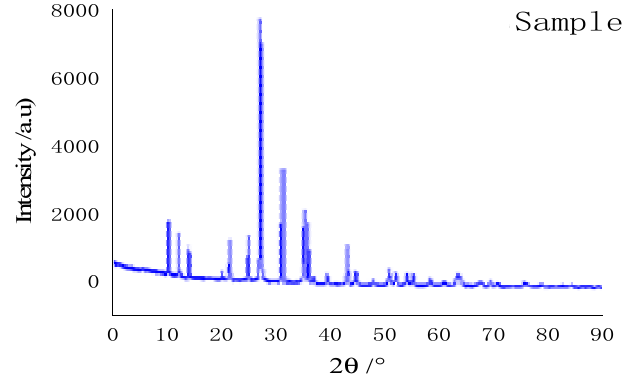
Figure 6. XRD pattern of sample.